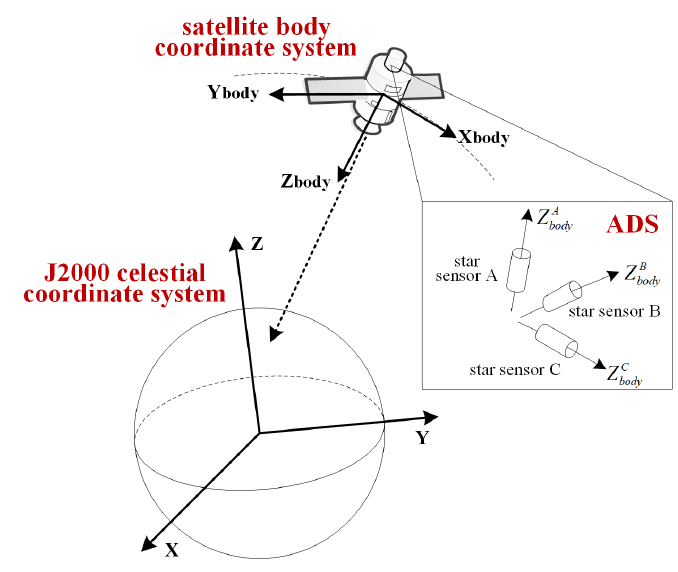
Figure 1. Satellite attitude determination by the star sensor in the J2000 celestial coordinate